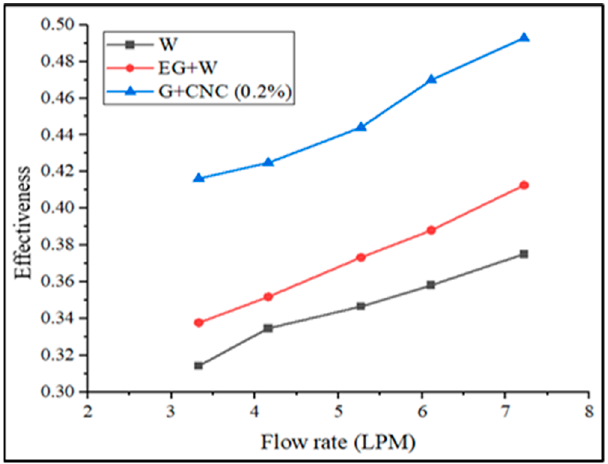
Figure 18. Effectiveness of automobile radiator.